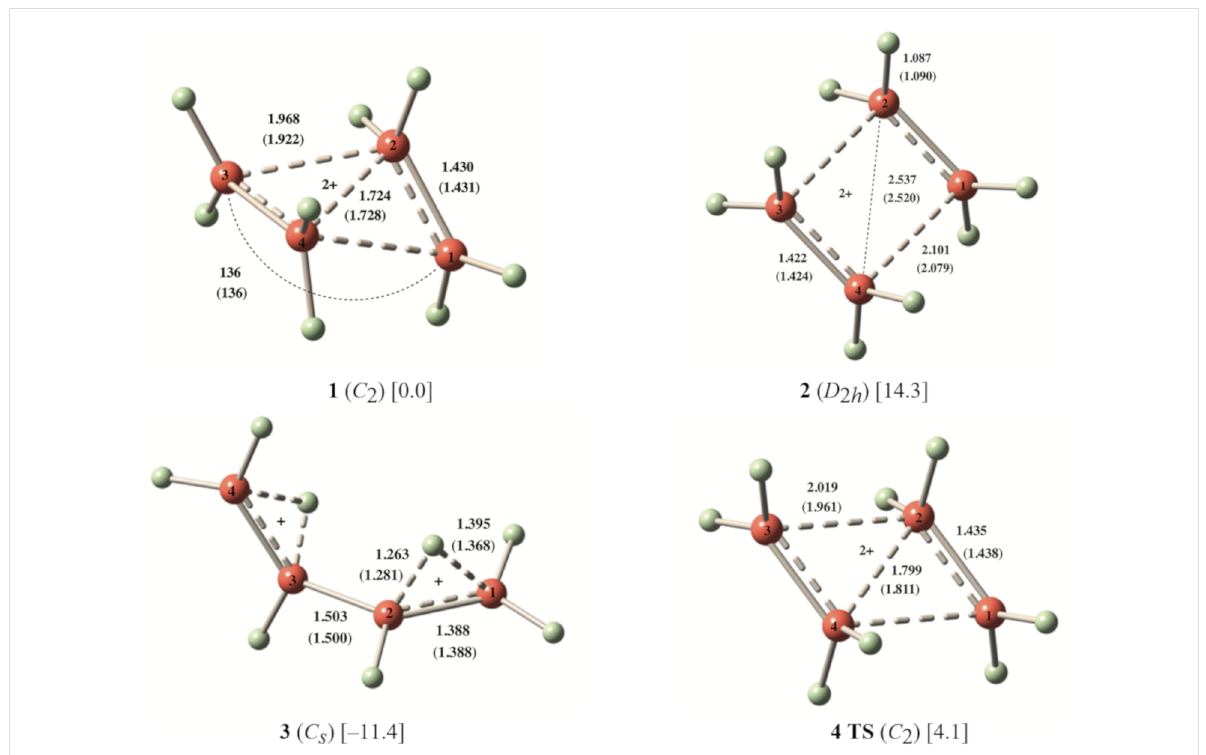
Figure 1: CCSD(T)/cc-pVTZ (MP2/cc-pVTZ) optimized structures and relative energies [in kcal/mol] of 1 – 4 .